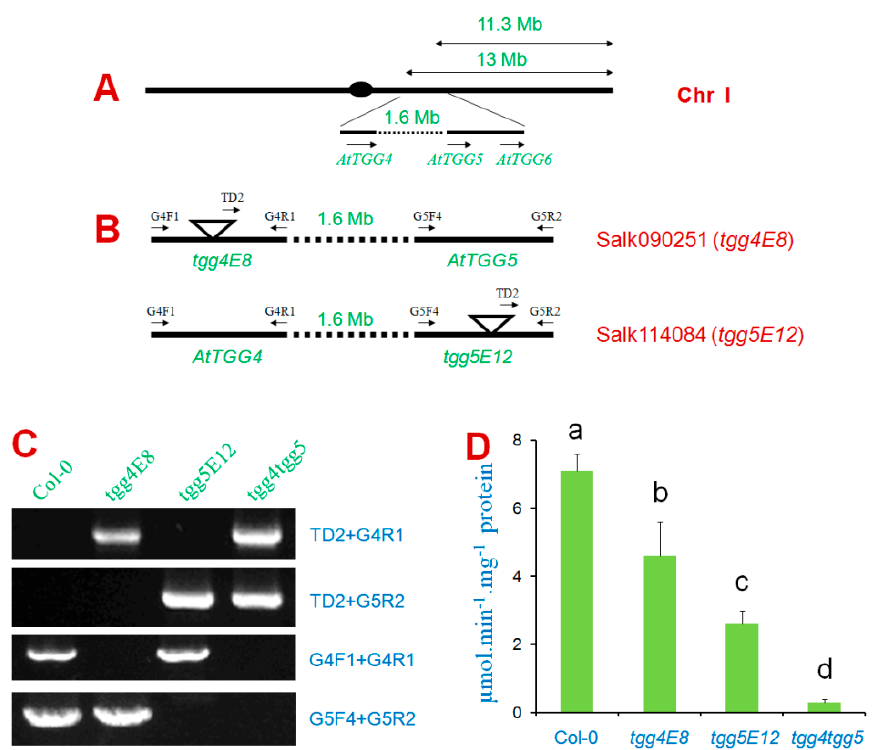
Figure 4. Schematic presentations of PCR primers and verification of single and double gene mutants in A. thaliana . ( A ) Relative locations of three Myr II genes in Chromosome I (Chr I) of A. thaliana ; ( B ) schematic of PCR primers used to identify T-DNA insertion and homozygous mutants; the triangles stand for the T-DNA insertions in the relevant genes; ( C ) confirmation of T-DNA insertion in the single and double mutants using four primer pairs; and ( D ) myrosinase activity in roots of the single and double mutants; different letters on the columns indicate significant difference at 1% significant level.